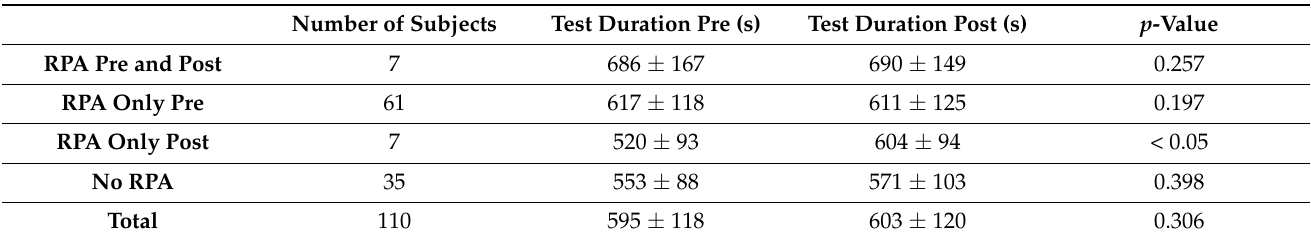
Table 2. Comparison of treadmill test duration (s) between the first test held before the pandemic (pre) and the second test held during the pandemic (post) in a group of young patients with congenital heart disease. RPA: regular physical activity.